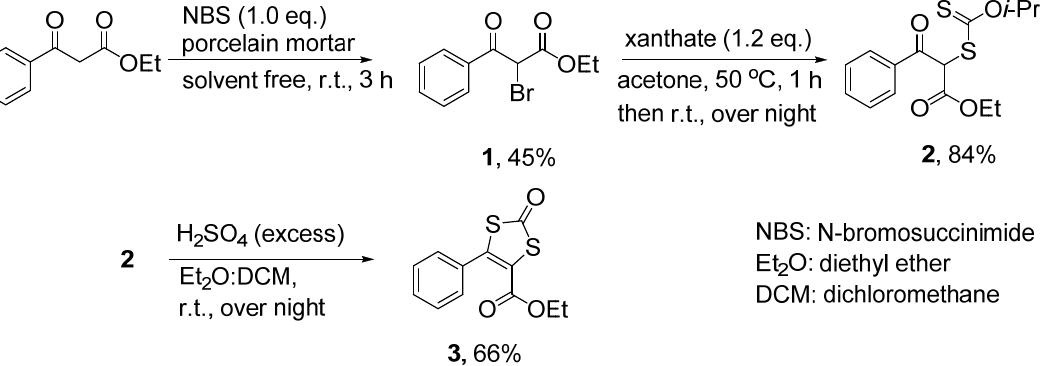
Scheme 1. The three-step preparation of ligand precursor ecpdt = CO ( 3 ) from commercially available